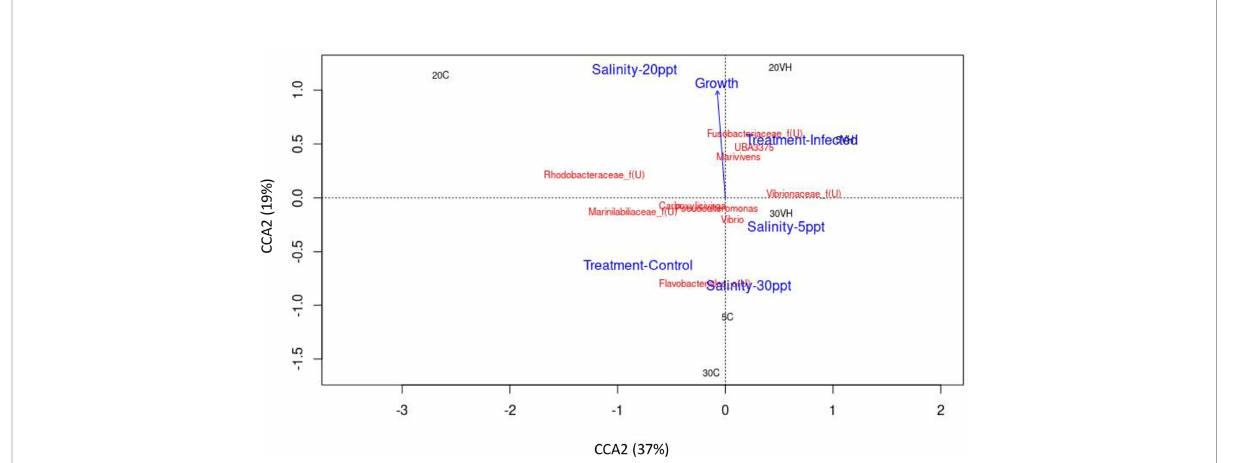
FIGURE 10 The correlation between gut microbiota of Litopenaeus vannamei cultured at different salinity levels and exposed to Vibrio harveryi infection with environmental or operational variables using Canonical correspondence analysis (CCA). The arrow length represents the strength of the correlation between the environmental variables and the microbes. The longer the arrow length, the stronger the correlation. The perpendicular distance between microbes and environmental variable axes in the plot re fl ects their correlations. The smaller the distance, the stronger the correlation. Treatment-Control, Control group. Treatment-Infected, Vibrio harveyi infected group, Salinity-5ppt, 5 ppt; Salinity-20ppt, 20 ppt; and Salinity-30ppt, 30 ppt. Growth (Growth increment of